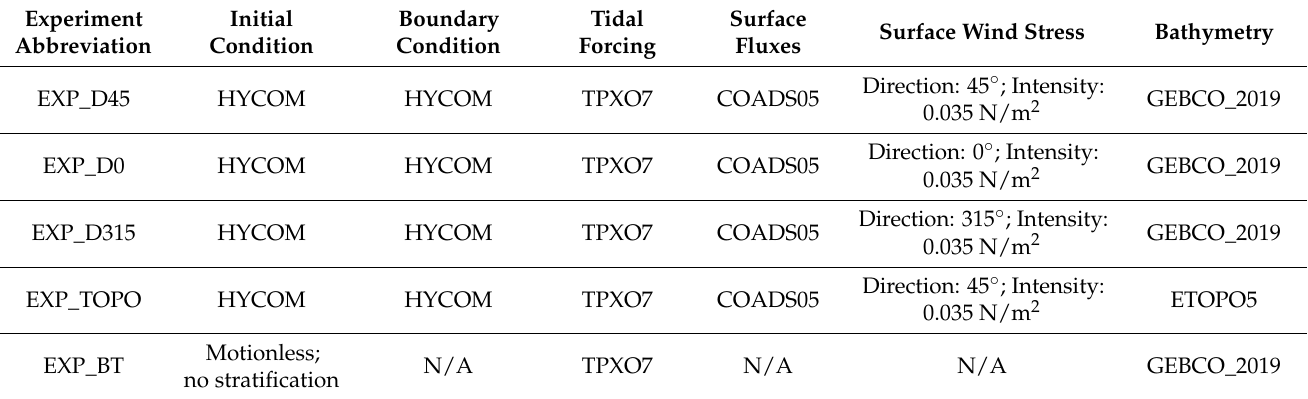
Table 1. Configurations of realistic numerical